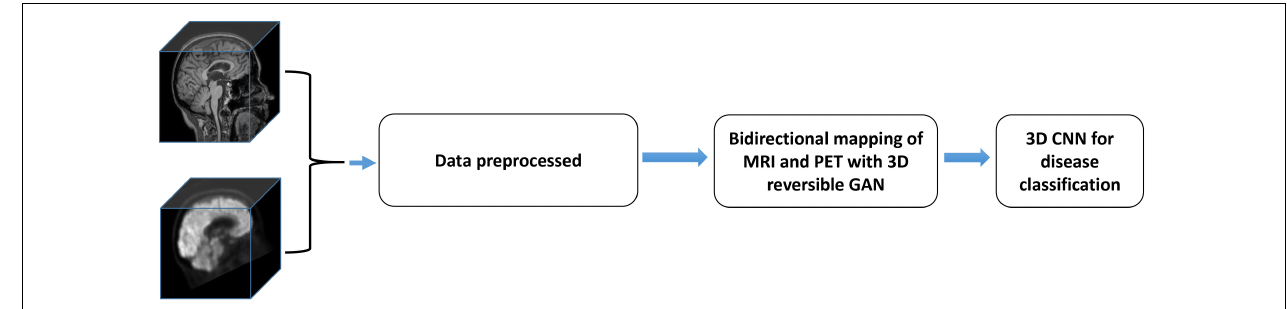
FIGURE 1 | The overall flow chart of the proposed method. It includes three parts, and the data is preprocessed first. RevGAN was then used to synthesize MRI and PET and to evaluate the image quality. Finally, we verify the impact of the synthesized images on disease classification.